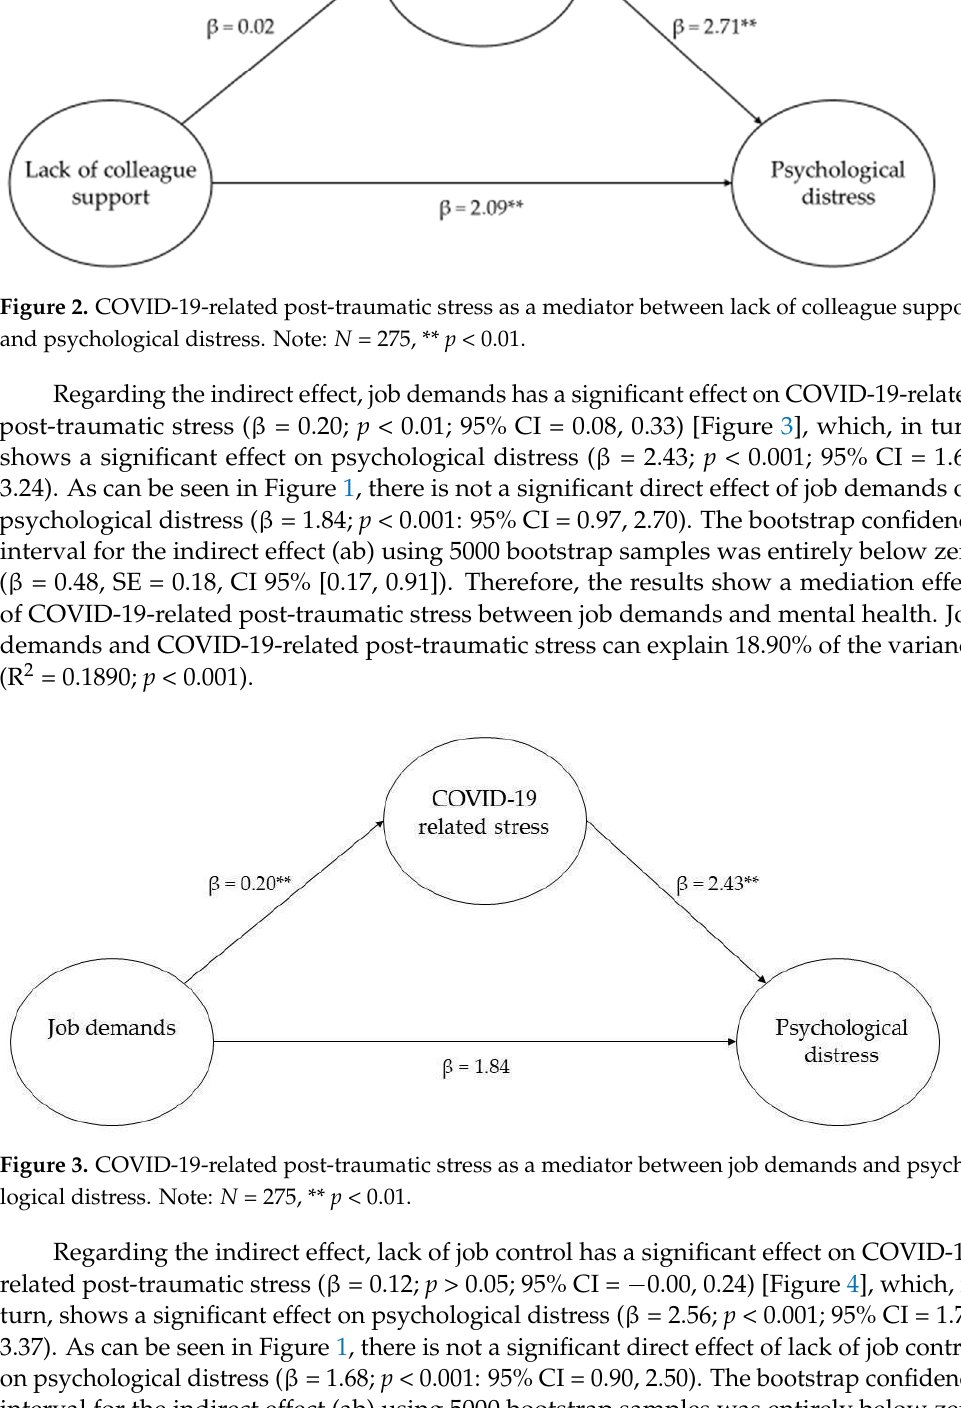
Figure 1. COVID-19-related post-traumatic stress as a mediator between lack of supervisor support and psychological distress. Note: N = 275, ** p < 0.01, * p < 0.05.